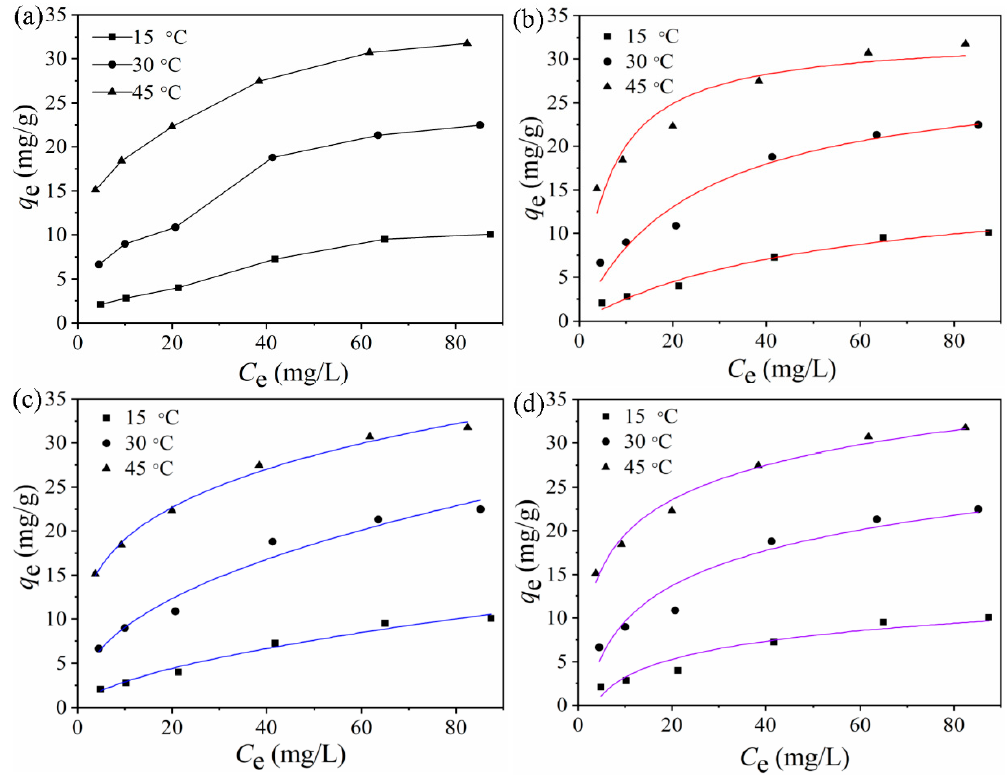
Figure 6. ( a ) Adsorption isotherms for Cd(II) adsorption onto graphene oxide at different initial concentration; ( b ) Langmuir model; ( c ) Freundlich model; ( d ) Temkin model: m / V = 84 mg/L, t = 24 h, pH = 6.00 ± 0.01, T = 15, 30, 45 °C.